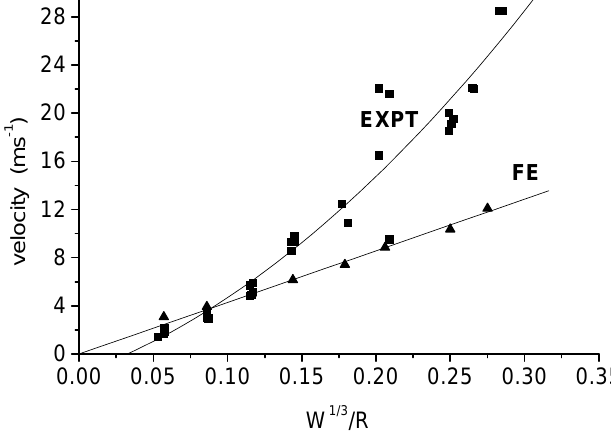
Fig. 9. Comparison of finite element and experiment (EXPT) results for velocity of the test plate